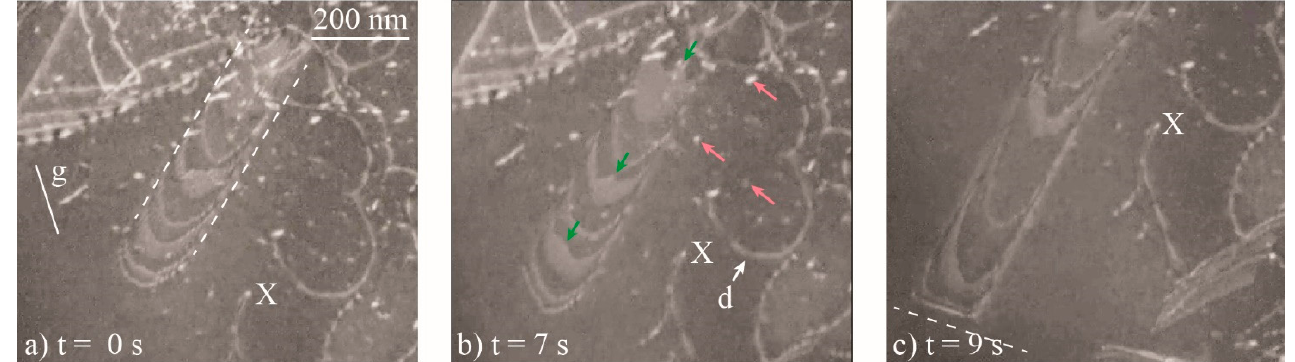
Figure 8. Progression of a mechanical twin in the γ phase of the TNM + alloy as observed by in situ tensile experiment in a TEM at room temperature. ( a ) Initial situation (t = 0 s); ( b ) progression of the twin; and ( c ) blocking of the twin against another out-of-contrast twin whose direction is indicated by the white dotted line.